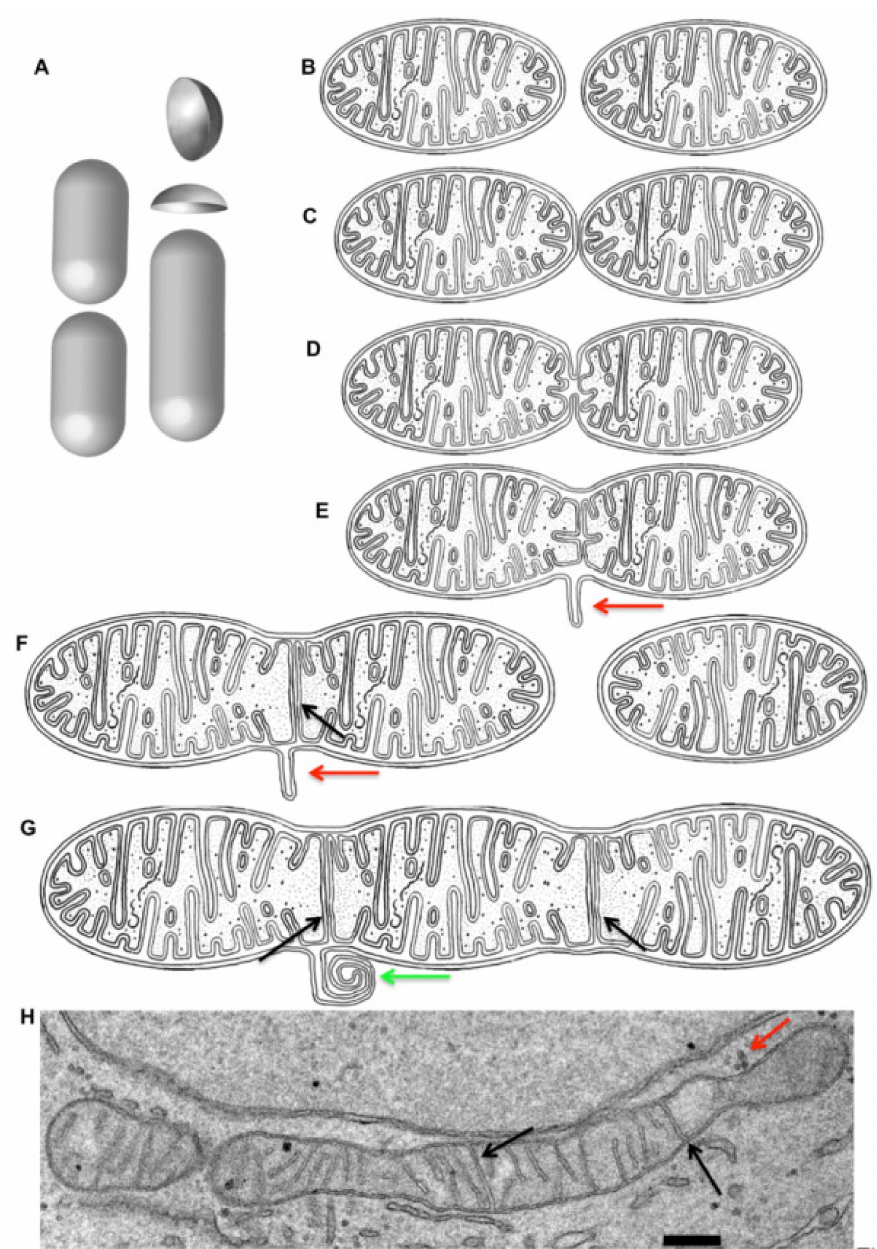
Figure 5. After mitochondria fusion the outer mitochondrial membrane becomes excessive. ( A ) Surface area of two ovoid figures before and after their fusion. Two half-spheres are excessive. ( B – G ) Stages of two consecutive mitochondria fusions. The fusion leads to the formation of excess of the surface area of the outer mitochondrial membrane, with the formation of the membrane protrusion (red arrow), which is then transformed into the multi-lamellar organelle (green arrow). Immediately after mitochondrial fusion the wall between the two mitochondria matrix compartments, derived from two mitochondria, is preserved (black arrows in F , G ). ( H ) Example of long mitochondrion with such walls (black arrows). Thus, a mitochondrion formed after several consecutive fusions contains one or several partition walls (black arrows). Bar: 280 nm ( H